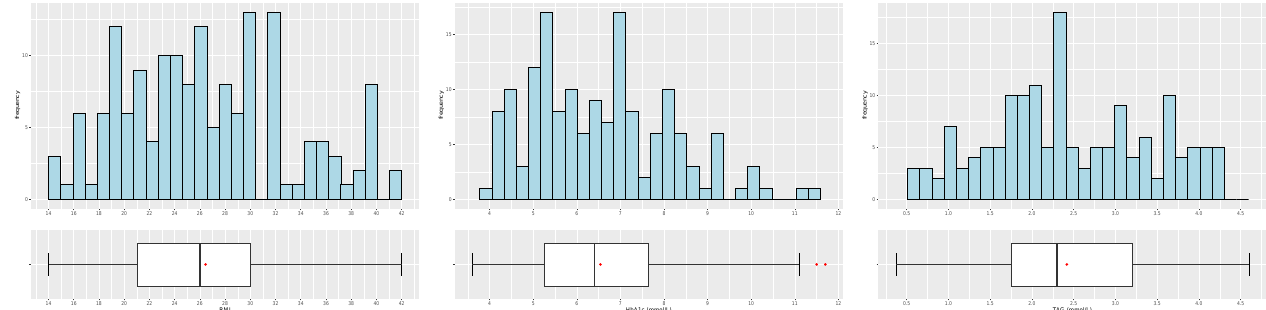
Figure 8. Distribution of the patients by BMI ( left ), HbA1c ( center ) and TAG ( right ); see abbreviations in